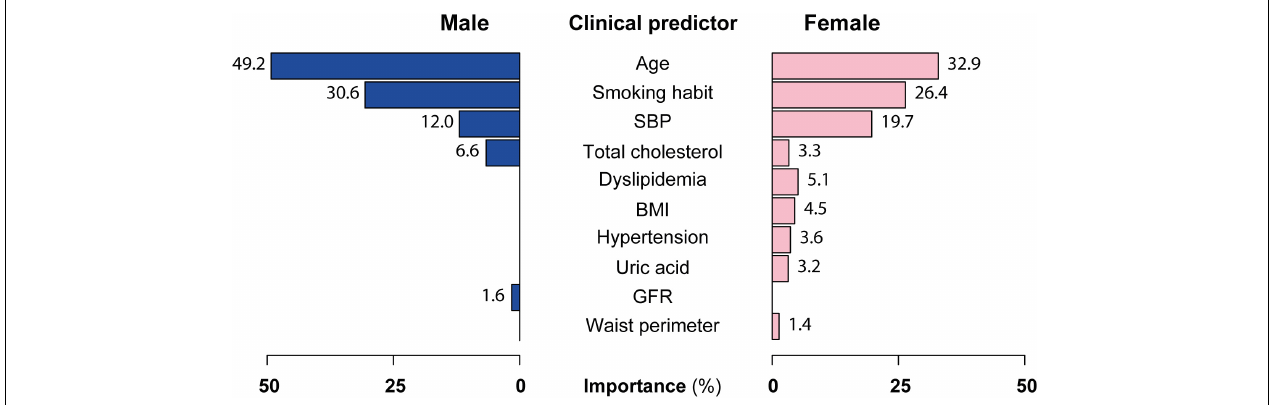
FIGURE 4 | Clinical predictor importance in the PASAP-ILERVAS in both sexes. A variable importance score was calculated using the improvement measure attributable to each predictor in its role as splitter, plus the goodness for all splits in which it was a surrogate. The values of importance were scaled up to sum 100%. SBP, systolic blood pressure; BMI, body mass index; GFR, glomerular filtration rate. TABLE 2 | Internal and external validation of the PASAP-ILERVAS. PASAP-ILERVAS Internal validation External validation Men Women Men